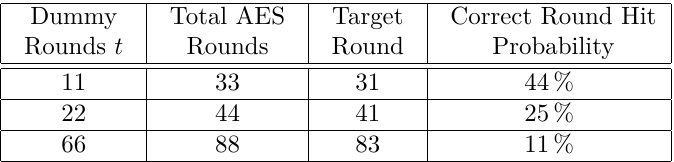
Table 4: Occurrence of dummy round hits for infective